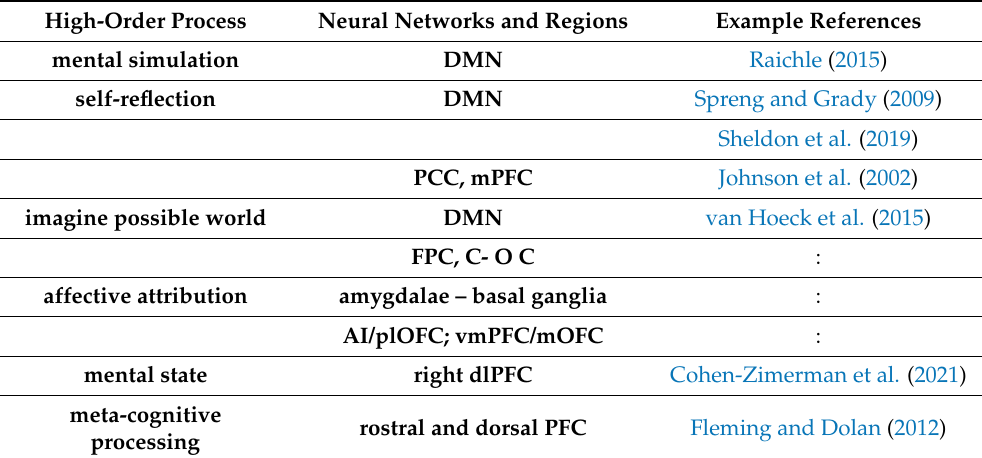
Table 1. Resolving the cognitive–affective nexus: mapping to large-scale attentional networks. High-Order